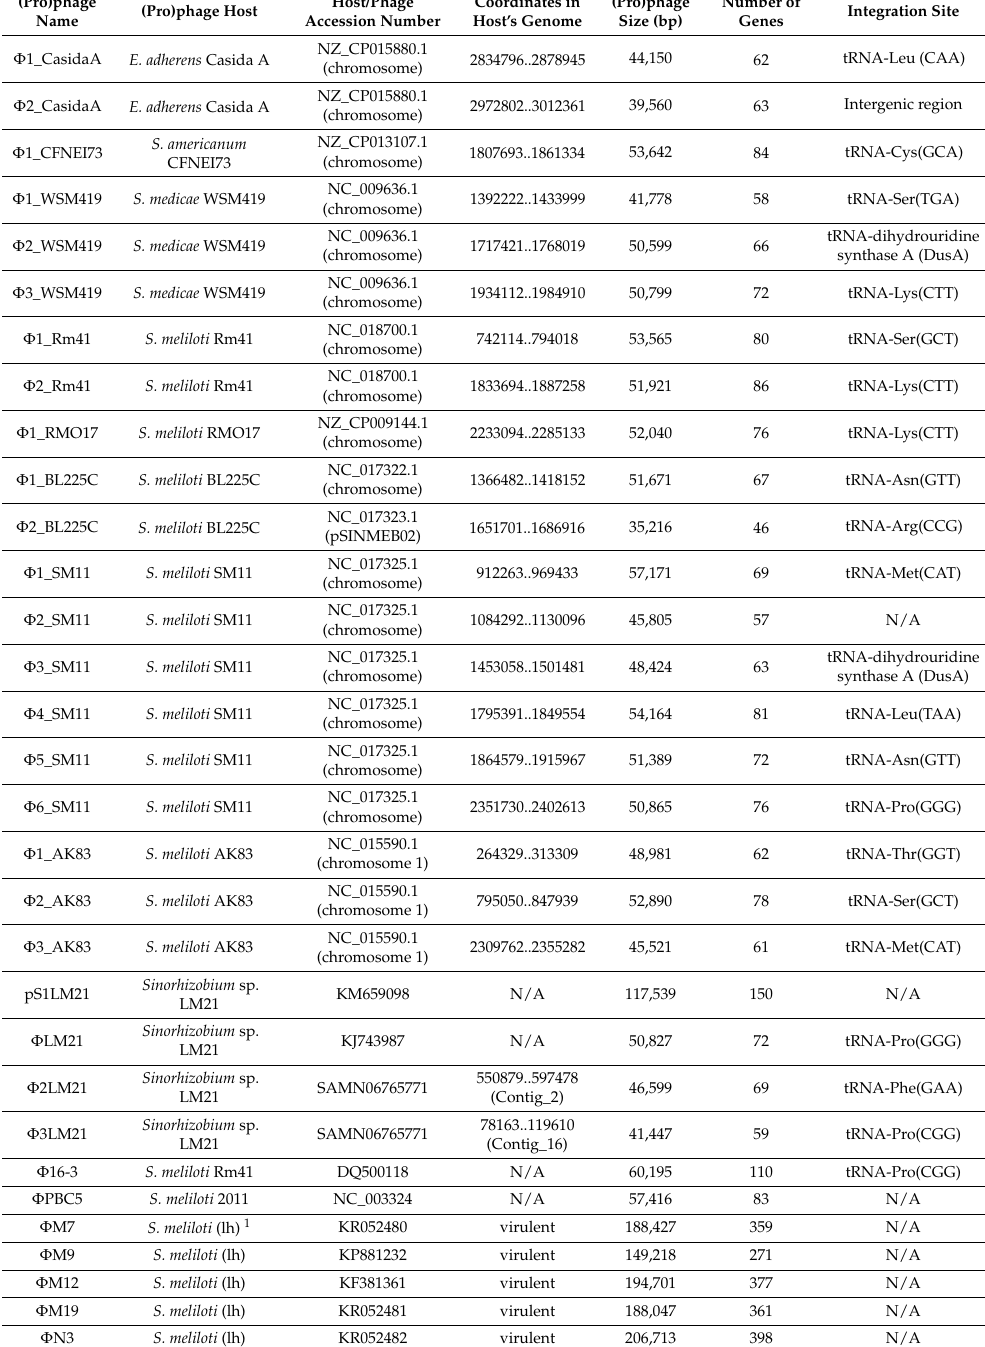
Table 1. Summary of the general features of Sinorhizobium / Ensifer